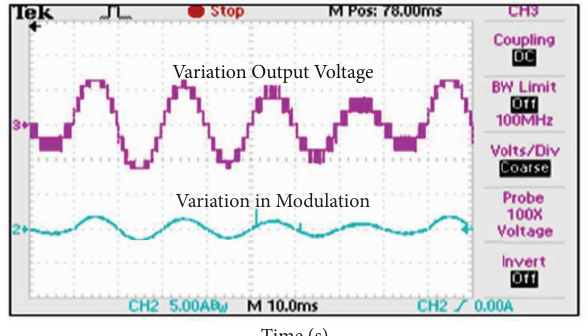
Figure 21: Inductive load current